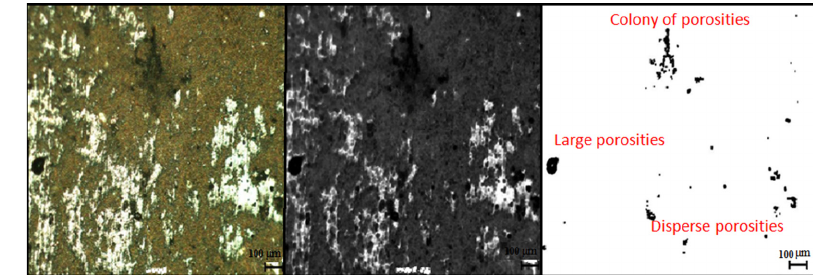
Figure 4. sequence of 2D images treatment to carry out the 3D reconstruction of the